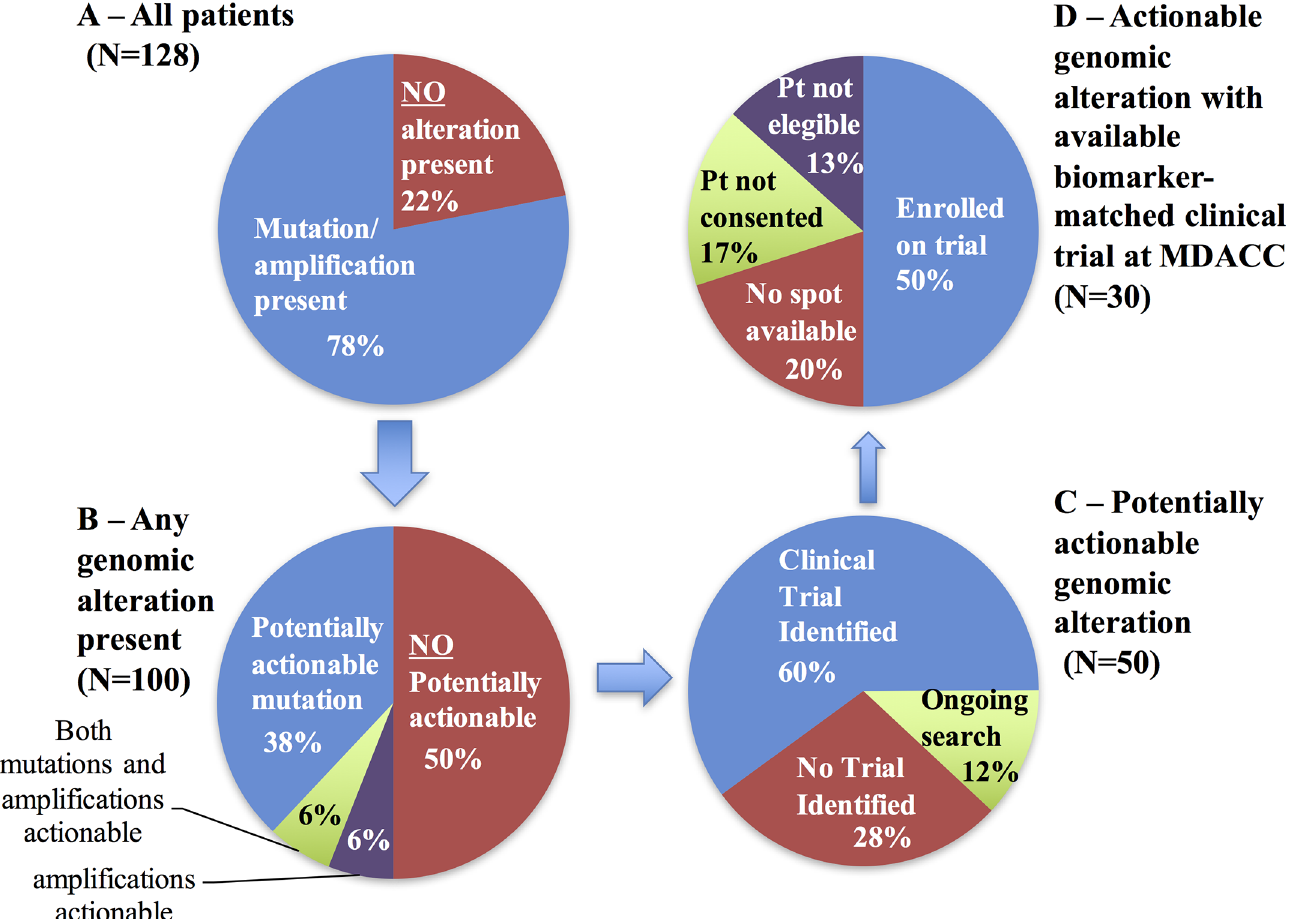
Fig 2. Clinical utility of cfDNA sequencing results. (A) Detectablemutations and/or amplification were present in 78% of patients. (B) 50% of these patients (N = 50) had “potentially actionable”mutations and/or amplifications. (C) Among these, 60% (N = 30) patients had a clinicaltrial identified based on the matched biomarkerdetected from the cfDNA (D) 15 patients ultimatelyenrolledon a biomarker-based clinicaltrial. Pt = patient; MDACC = MD Anderson Cancer Center.